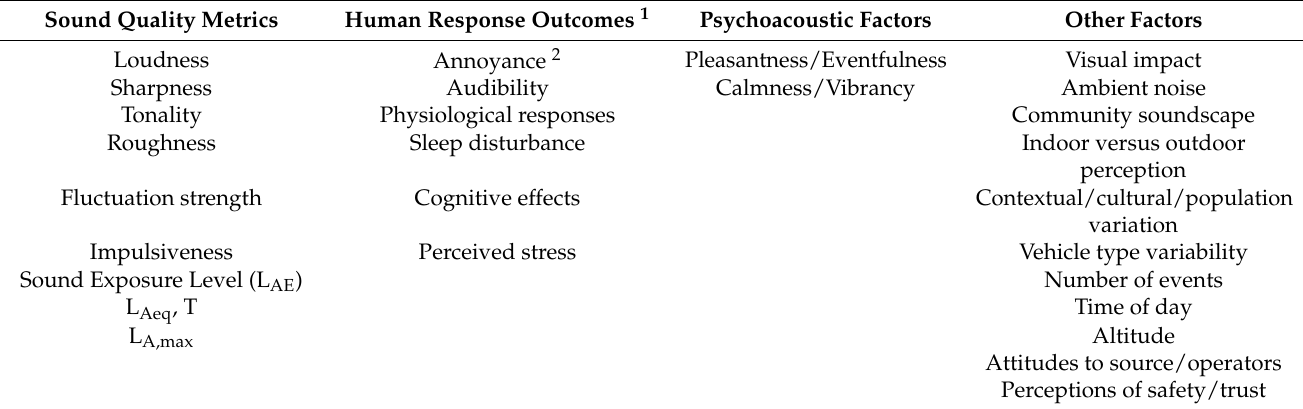
Table 2. Variables to be explored to build knowledge of the human responses to